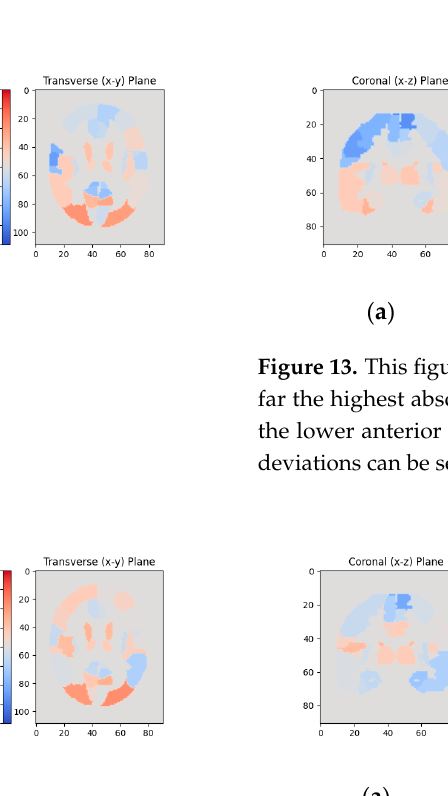
Figure 14. This figure shows the relative VOI deviations when using template T4 for patient P3. As in Figure 13, the left and right gyrus rectus VOIs experienced the largest deviations ( a ). However, these two VOIs with the highest deviations are less pronounced than in Figure 13, as also noticeable on the linear regression plot ( b ).